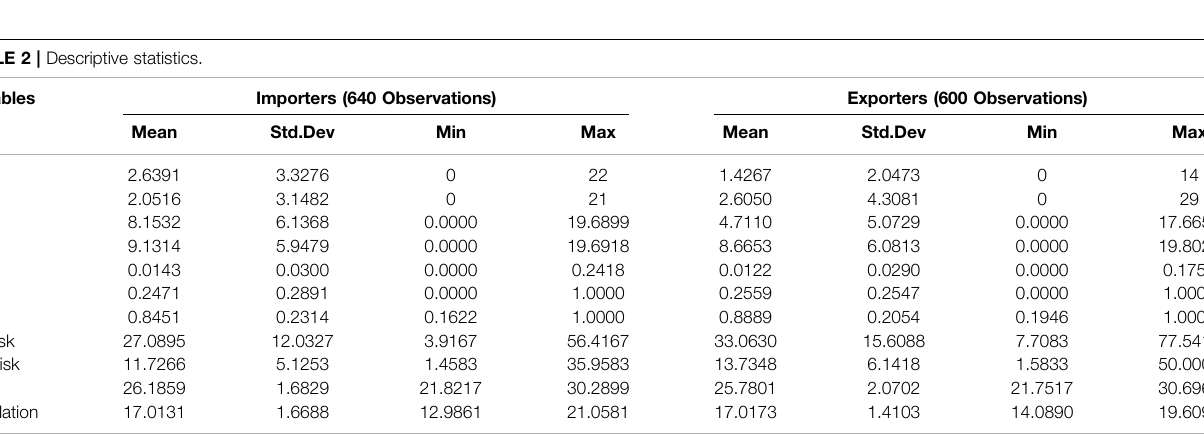
TABLE 2 | Descriptive statistics.